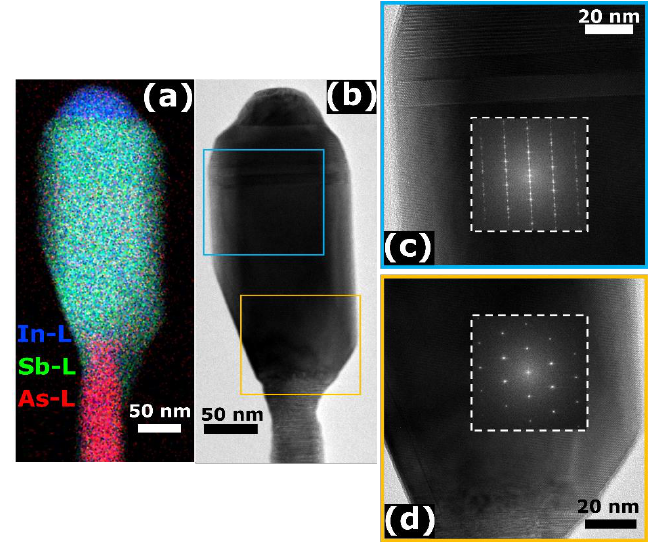
Figure 4. TEM analyses of the InAs / InSb NWs grown with F In = 0.2 Torr and F Sb = 0.7 Torr for 60 min. ( a ) EDX compositional map of a NW in which is visible the InAs stem in pink color, the InSb segment in green color and the In NP in blue. ( b – d ) show HR-TEM images of another NW with the FFTs of the selected portions (insets).